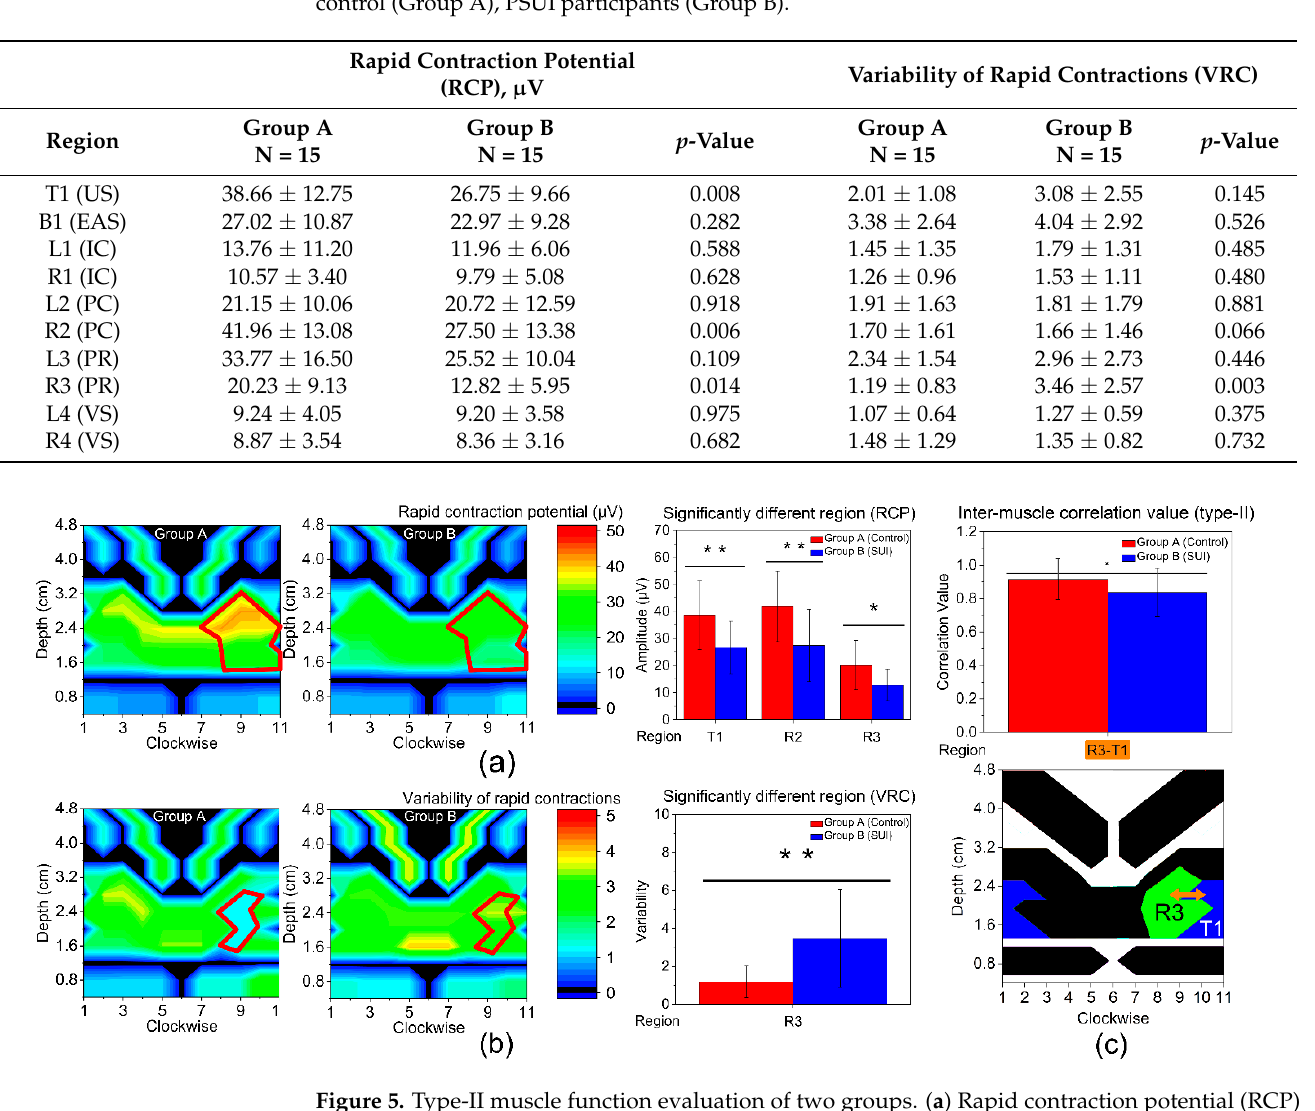
Table 4. Type-II muscle function assessment results of participants, postpartum and asymptomatic, control (Group A), PSUI participants (Group B).